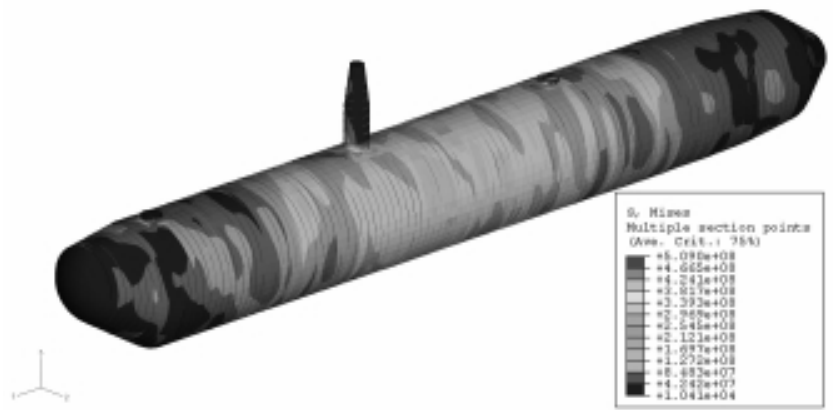
Fig. 14. Stress distribution at t = 0.20 sec.